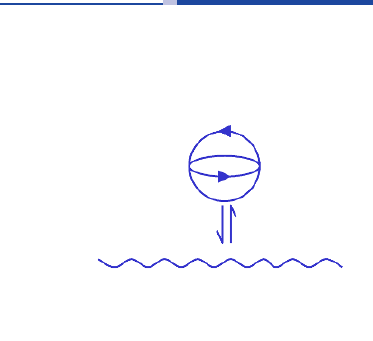
Figure 3. Maturana and Varela’s ideogram to denote the development engen- dered by interaction between cognitive